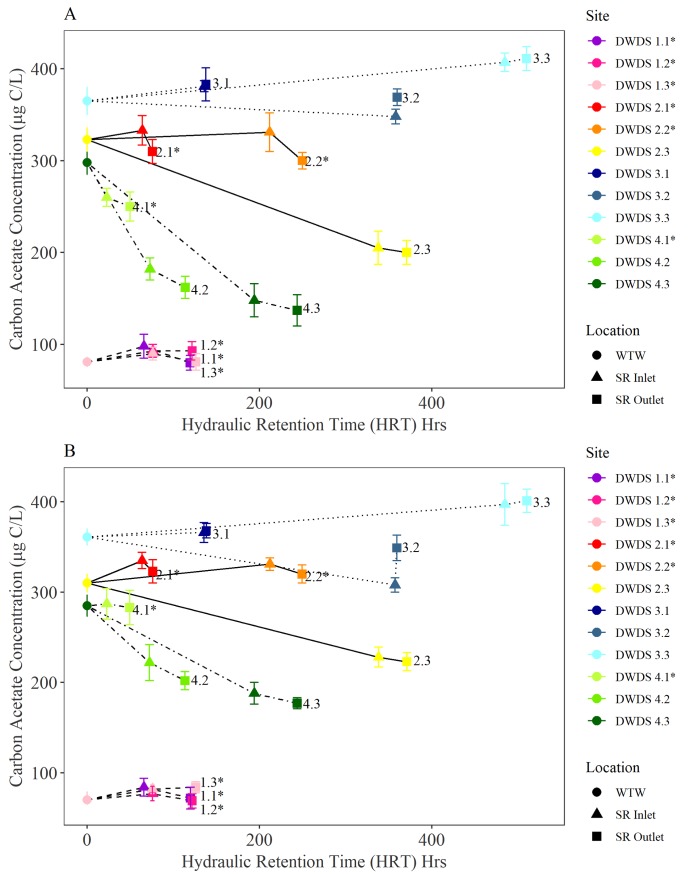
Variation in the AOC concentration along 4 DWDS during A) summer and B) winter (
Table 1
for DWDS details). AOC plotted with respect to the time that water has spent in the network, i.e. hydraulic retention time (HRT). Hydraulic residence time is calculated from the pipe and/or SR volume divided by the flow rate (l/s). Locations of samples are indicated by the key and follow the sequence post-treatment (WTW outlet) and through 3 service reservoirs (SR), inlet and outlet. Data is the annual average ± standard deviation. A network schematic of the SRs within each system is provided in Fig 1. SR marked with a * are pipe only systems (water does not pass through an un-sampled SR).